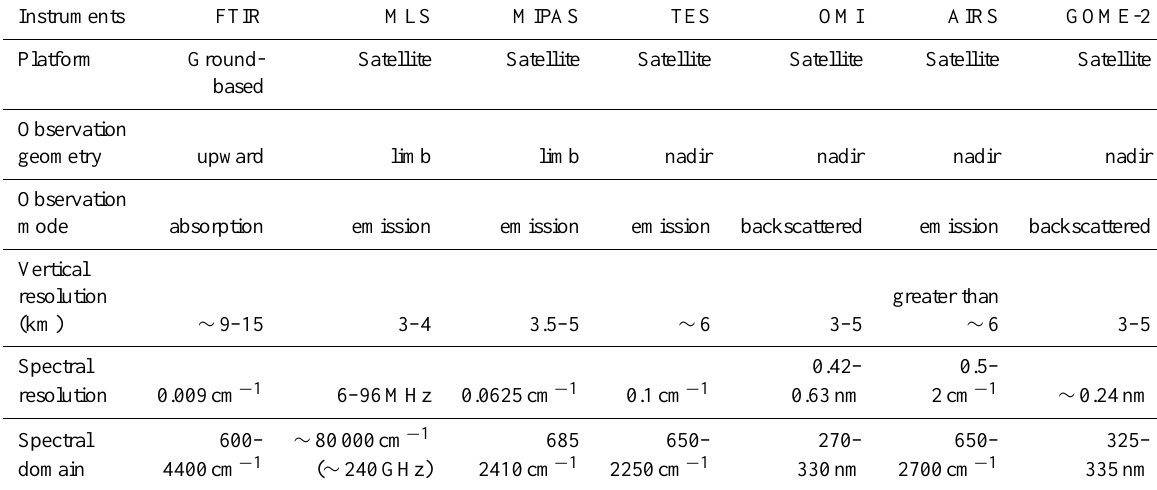
Table 1. Summary of the characteristics of the instruments and measurement systems of O 3 addressed in this study. Instruments FTIR MLS MIPAS TES OMI AIRS GOME-2 Satellite Satellite Satellite Satellite Satellite